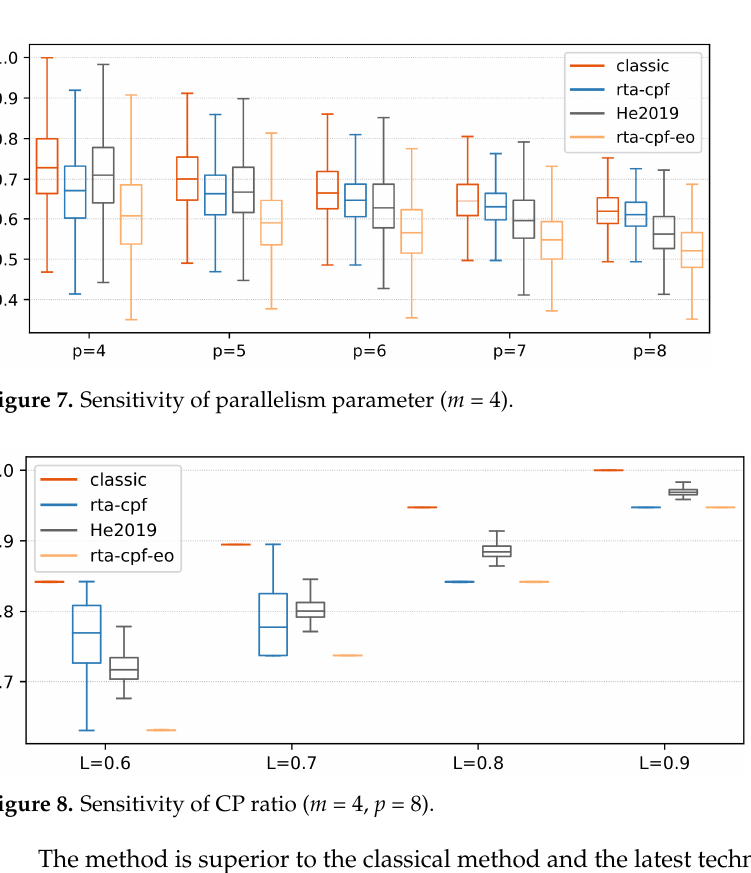
16 of 21 Figure 6. WC CT of DAG using different numeral of processors. 6.1.1. Sensitivity of DAG Priorities From some results, it is not easy to understand how the DAG attribute affects the WC maximum CT. To adapt to this situation, this experiment shows how the evaluated anal- ysis is sensitive to some DAG features. That is, by controlling the parameters of Dag and evaluating the maximum CT in the normalized value, we can see how much the perfor- mance of the analysis has changed. Otherwise, this will not be distinguished by the WC maximum CT or schedulability analysis. Specifically, we consider the following parame- ters in this experiment: (i) DAG parallelism (the maximum possible width when generat- ing a randomized DAG), p , and (ii) the ratio of DAG CP to total workload % L , where % L = L / C × 100%. Figure 7 evaluates the influence of CP length on the usefulness of the proposed method, m = 2. The CP varies from 60% to 90% of the total workload of the generated DAG. In this experiment, compared with the existing methods, the proposed analysis shows the most remarkable performance. For the proposed method, due to the change in the internal structure of the generated DAG (for example, L = 0.6), the WC maximum CT